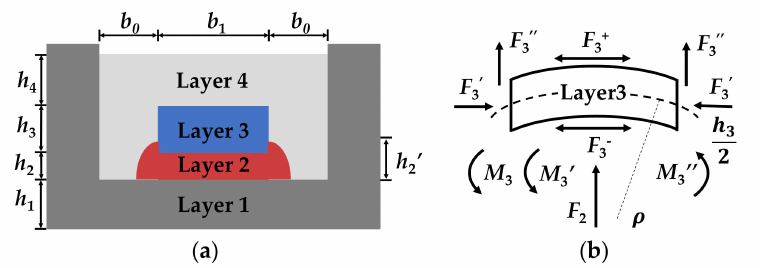
Figure 4. ( a ) Theoretical model of the MEMS pressure sensor; ( b ) mechanical analysis of Layer 3. According to the thermal expansion theory of composite structure, the strains of upper and lower surfaces of the connecting layers are equal in values but opposite in